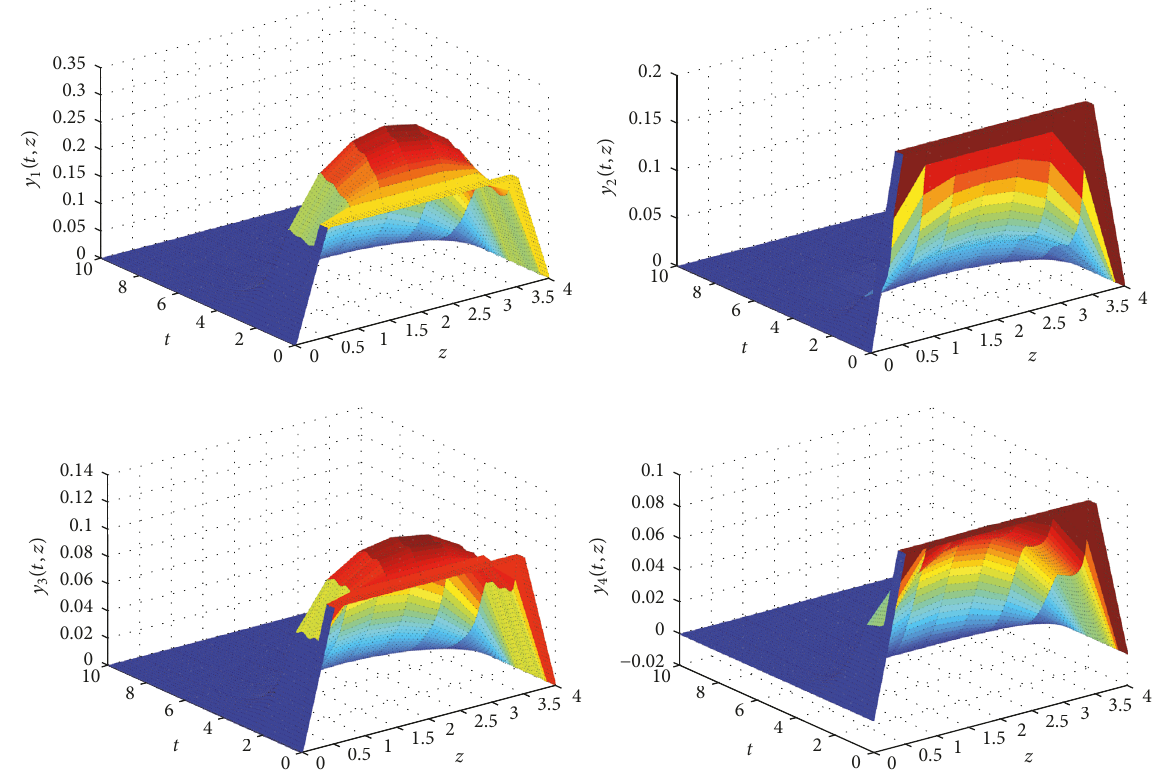
Figure 2: The trajectories of protein concentrations 𝑦(𝑡, 𝑧) for the genetic regulatory networks